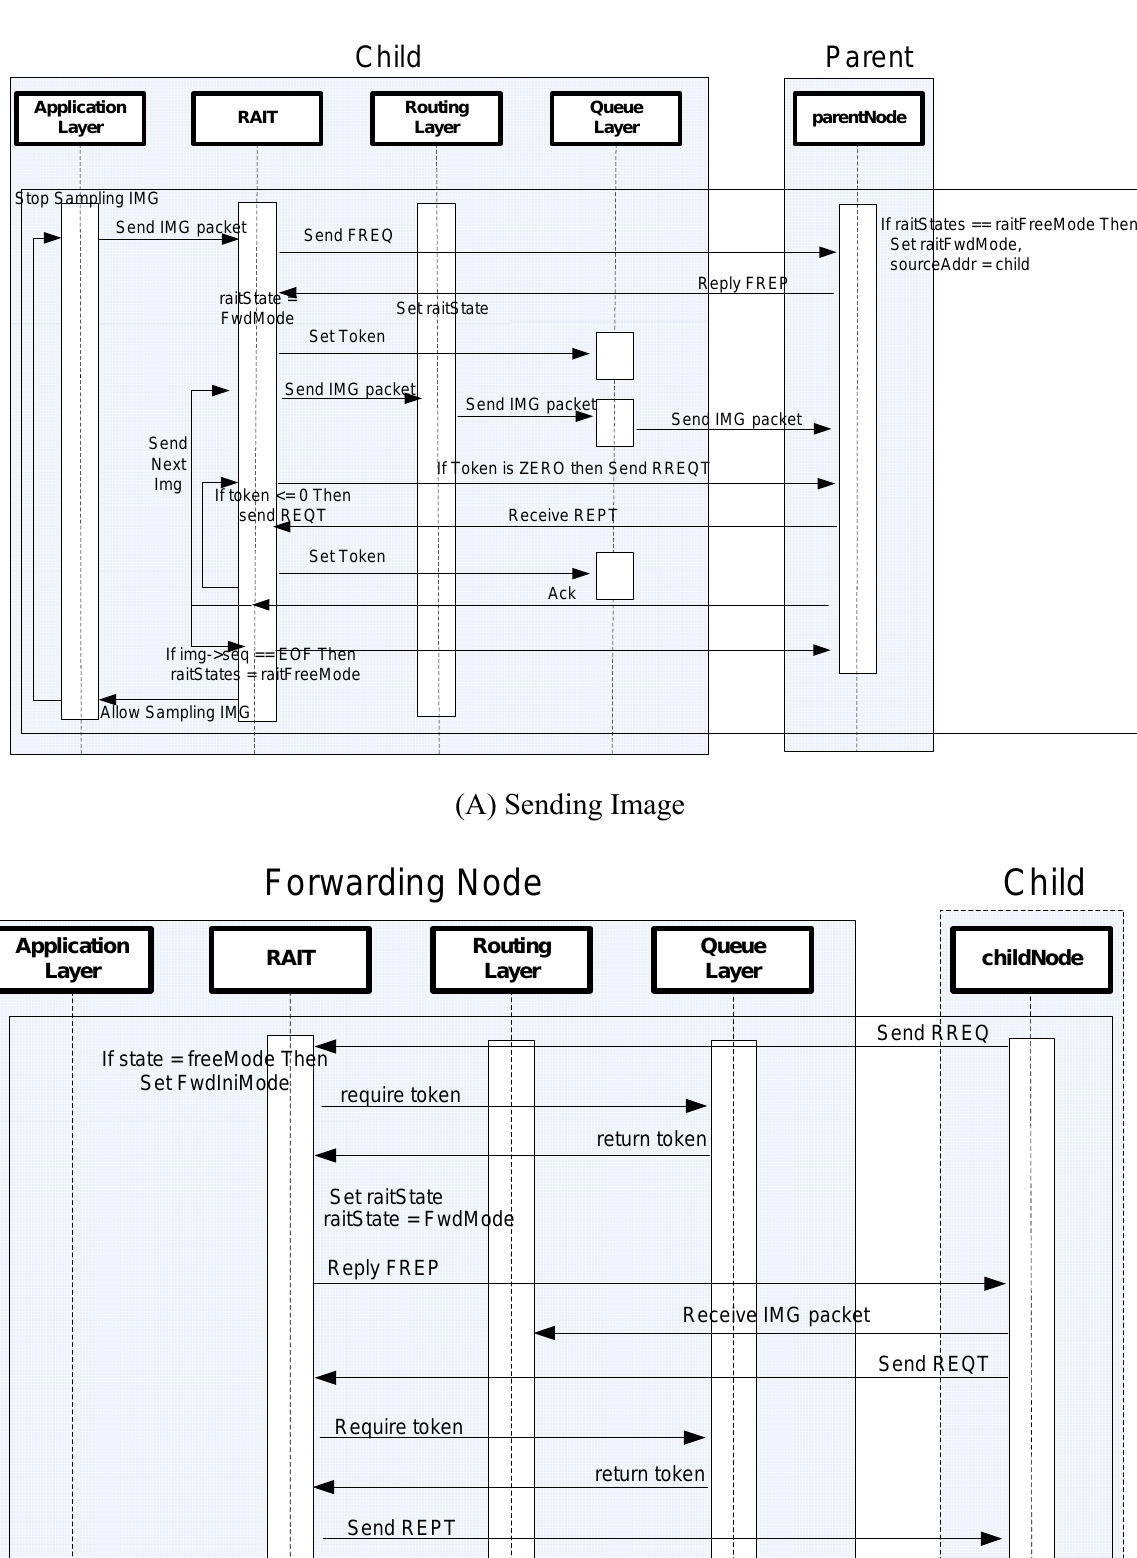
Figure 6. Sequence Diagram of